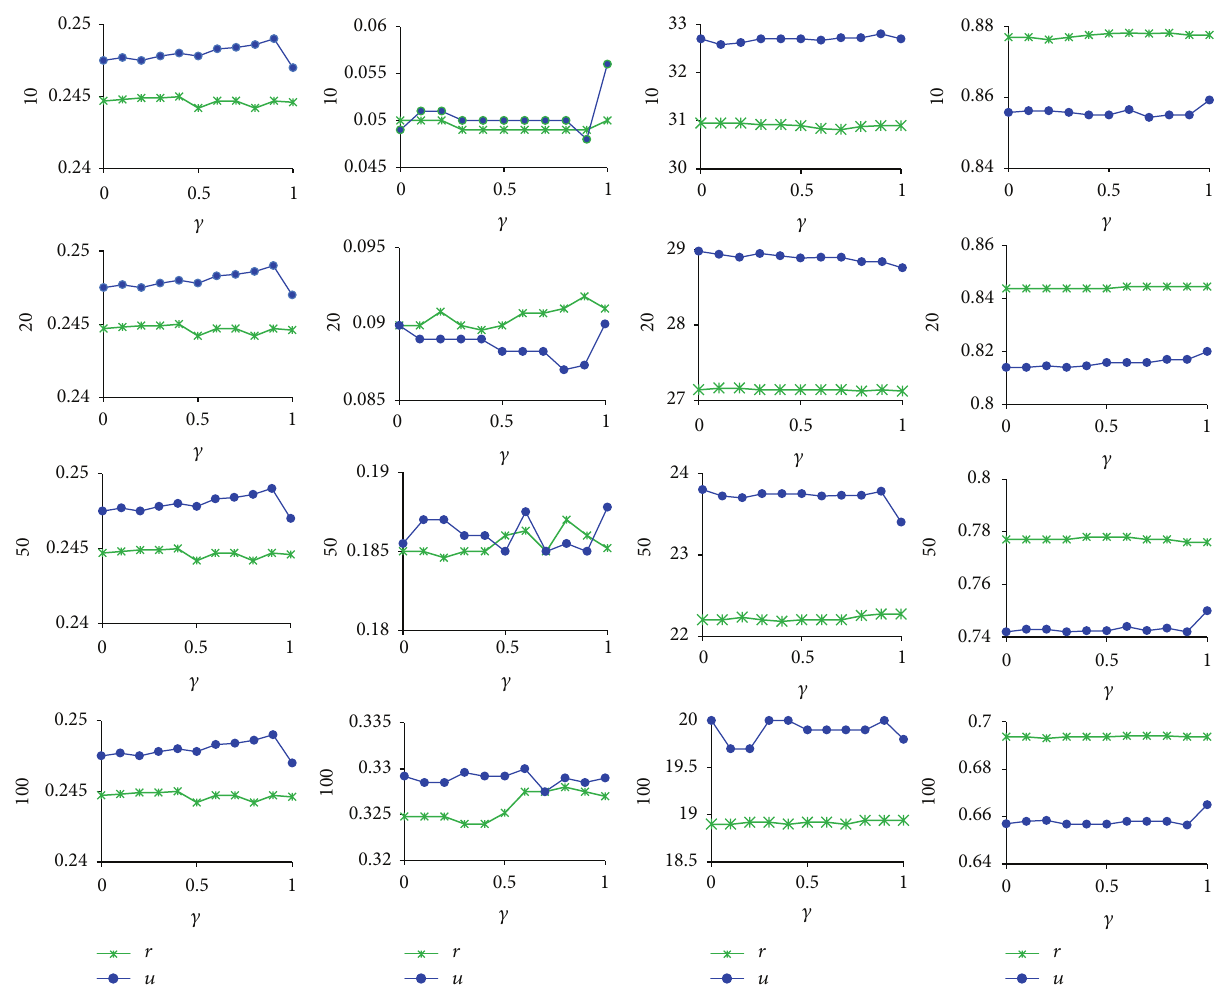
Figure 5: Results of RCBCR. Related instructions are shown in Figure